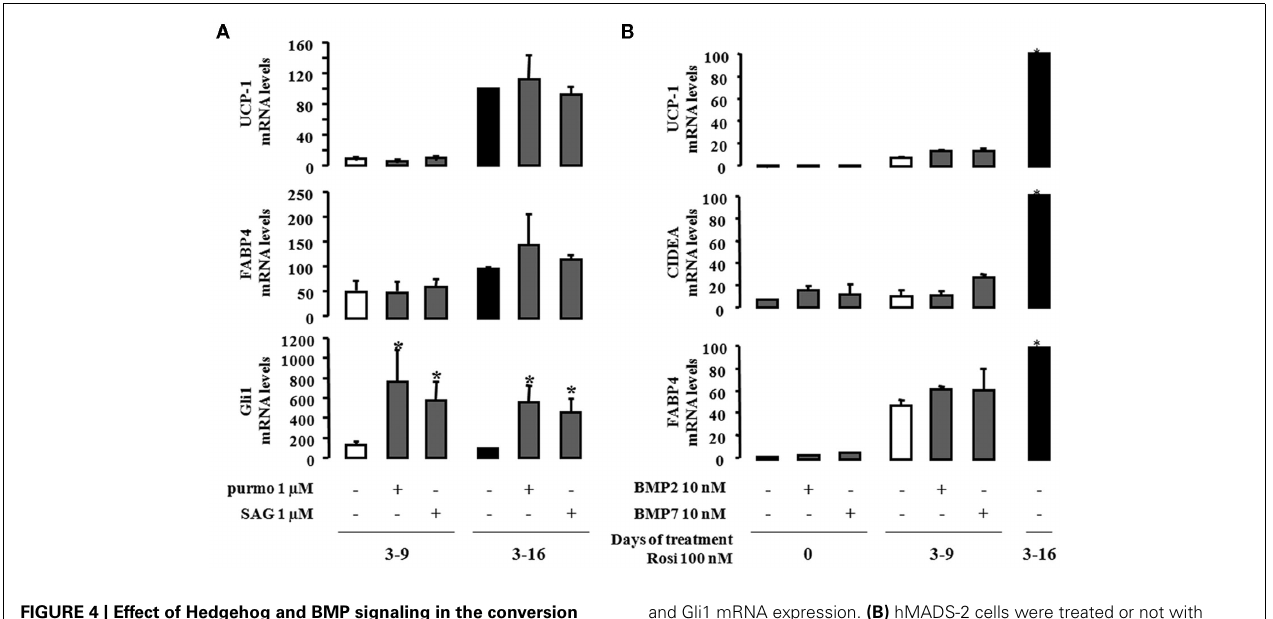
FIGURE 4 | Effect of Hedgehog and BMP signaling in the conversion of white to brown adipocytes. hMADS-2 cells were induced to differentiate into adipocytes in presence of 100nM rosiglitazone at the indicate times. (A) , Purmorphamine (purmo) or smoothened agonist (SAG) as effectors of the Hedgehog signaling pathway were added between days 14 and 18.Their effects were analyzed by measuring UCP1, FABP4,